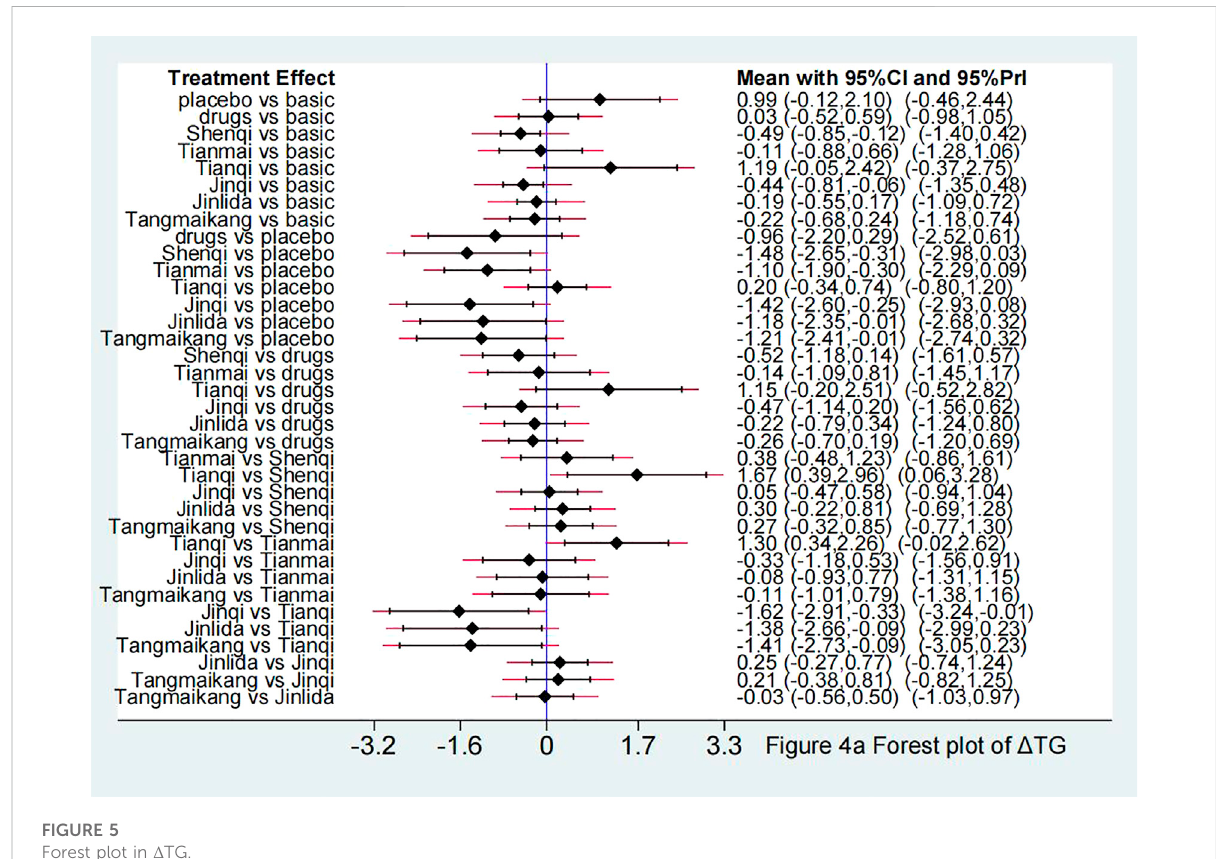
FIGURE 5 Forest plot in Δ